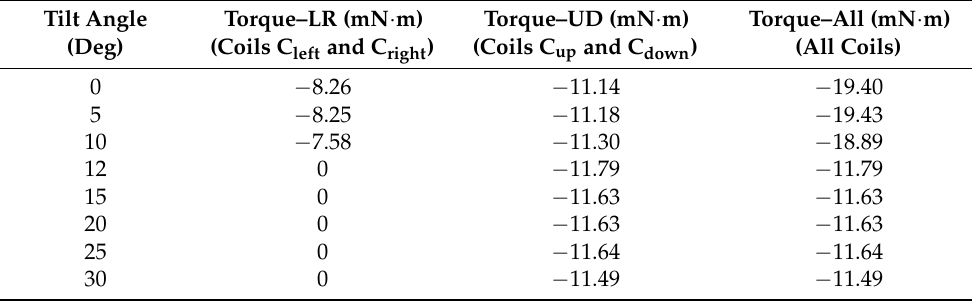
Table 3. The values of the torque with respect to the tilt angle along the X -axis for the Z